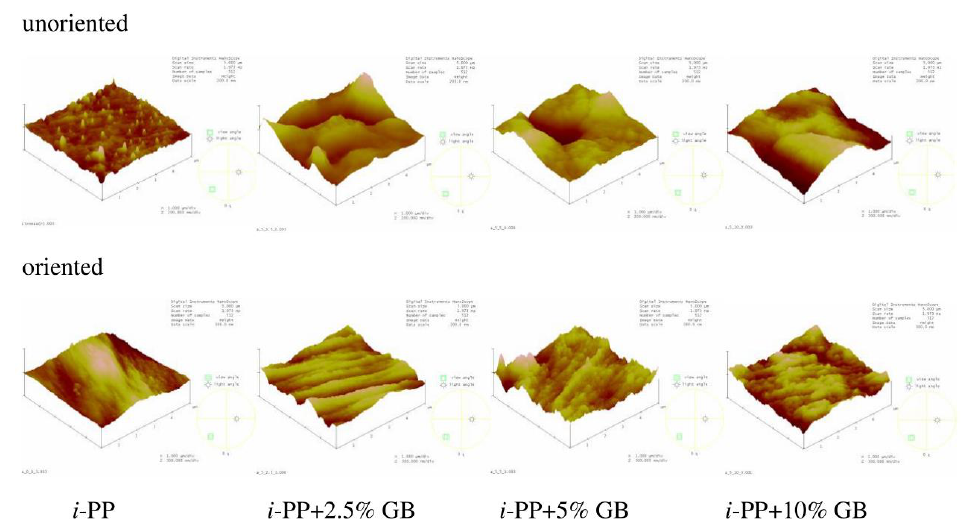
Figure 6. Atomic force microscopy (AFM) images of the unoriented ( top ) and oriented ( bottom ) neat i -PP film and i -PP films with different content of glass beads (GB). Scan area: 5 μm × 5 μm, z-scale for the unoriented films: 200 nm, for the oriented films: 300 nm.